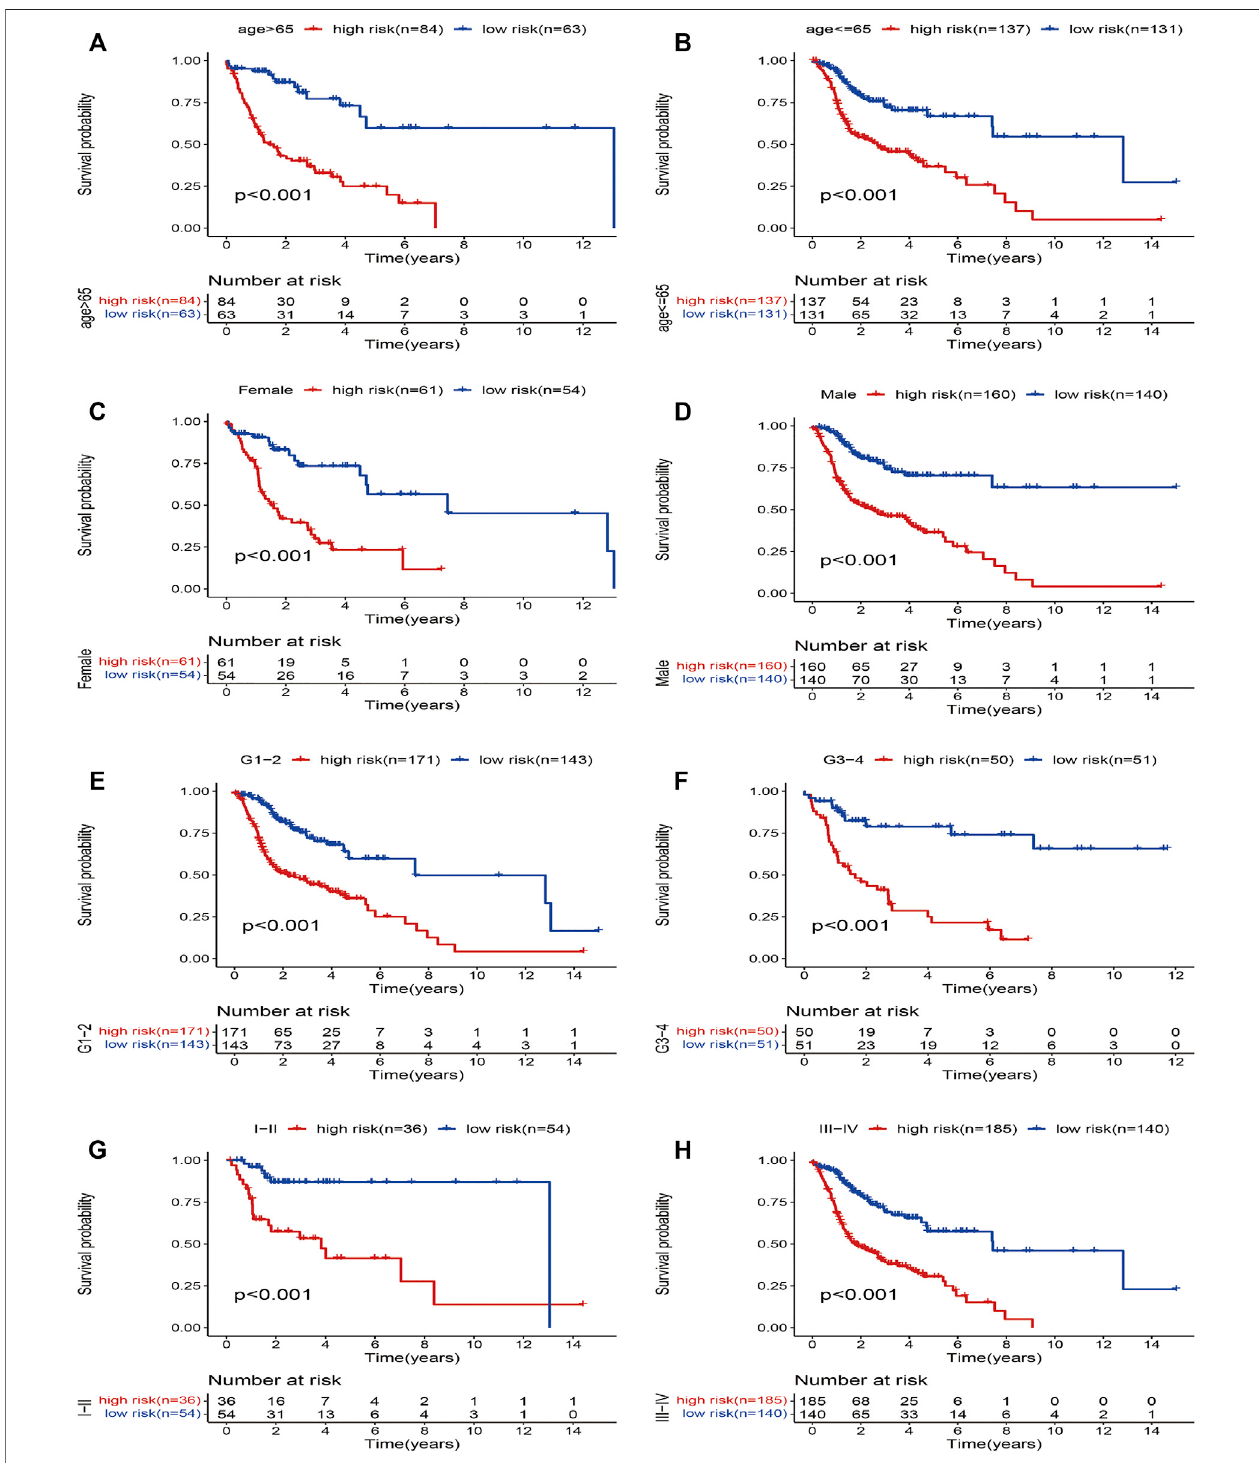
FIGURE 4 | Kaplan – Meier survival curves for the high- and low-risk groups strati fi ed by clinical factors. (A) age > 65 years, (B) age ≤ 65 years, (C) gender (female), (D) gender (male), (E) grades 1 – 2, (F) grades 3 – 4, (G) stages I – II, and (H) stages III – IV.